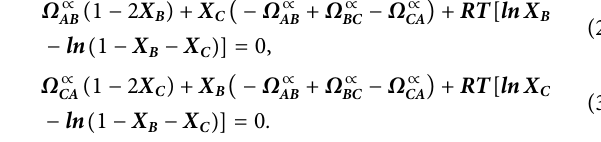
Frontiers in Materials |